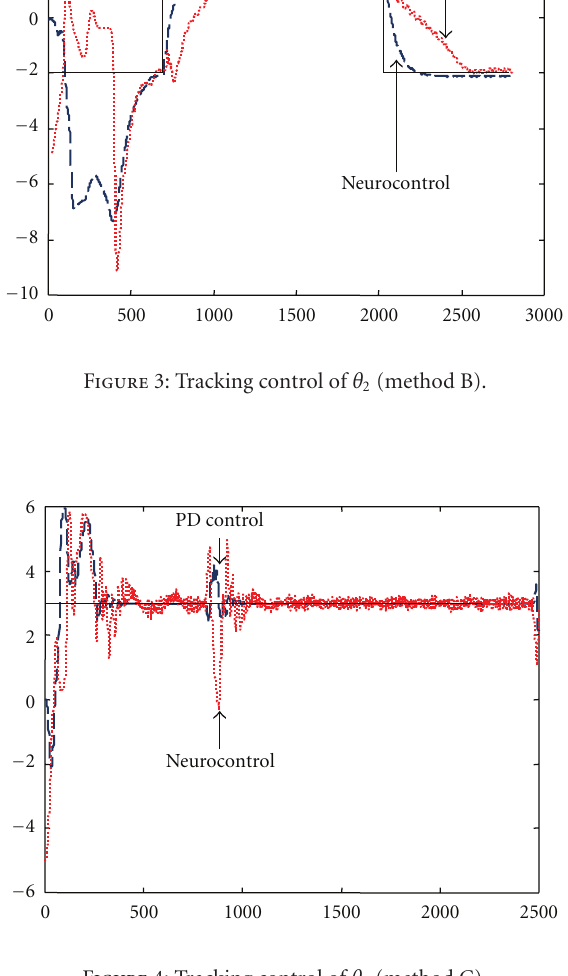
Figure 4: Tracking control of θ 1 (method C).